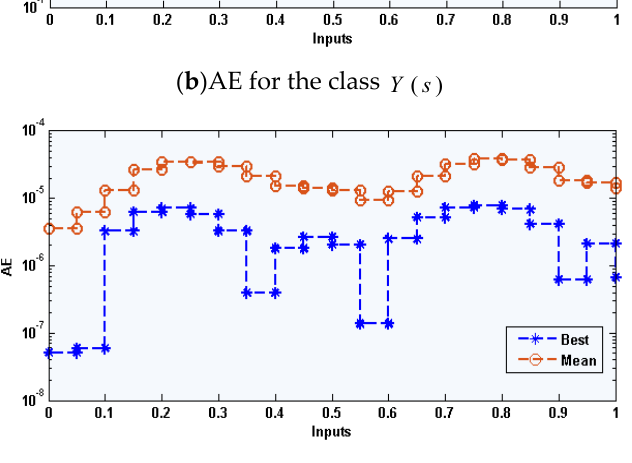
Figure 3. AE values for each class of the environmental and economic nonlinear model.